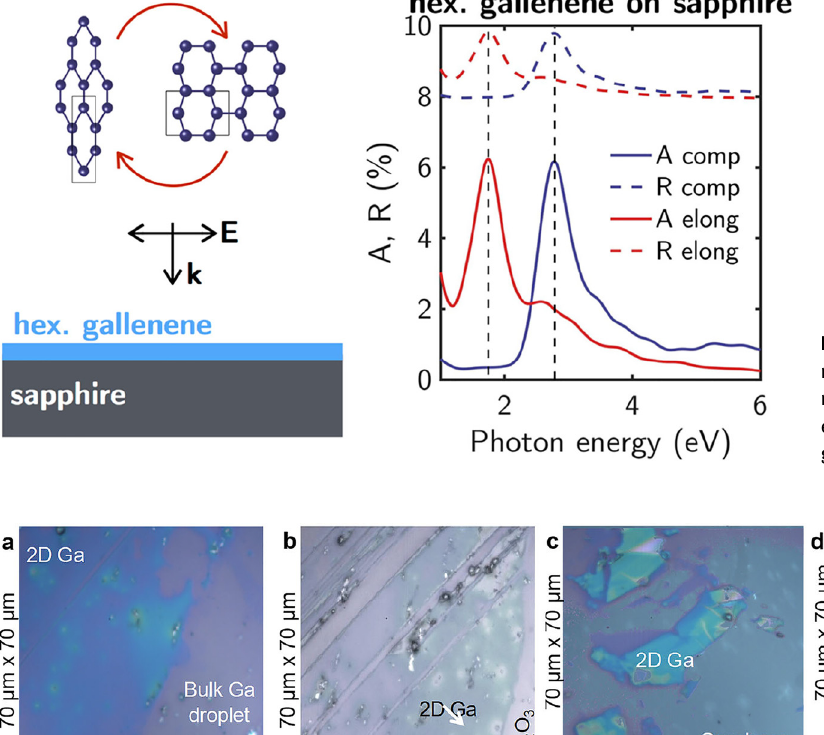
Figure 12: Absorbance ( A , solid line) and re fl ectance ( R , solid line) spectra of a monolayer of compressed (comp-blue) and elongated (elong-red) hexagonal